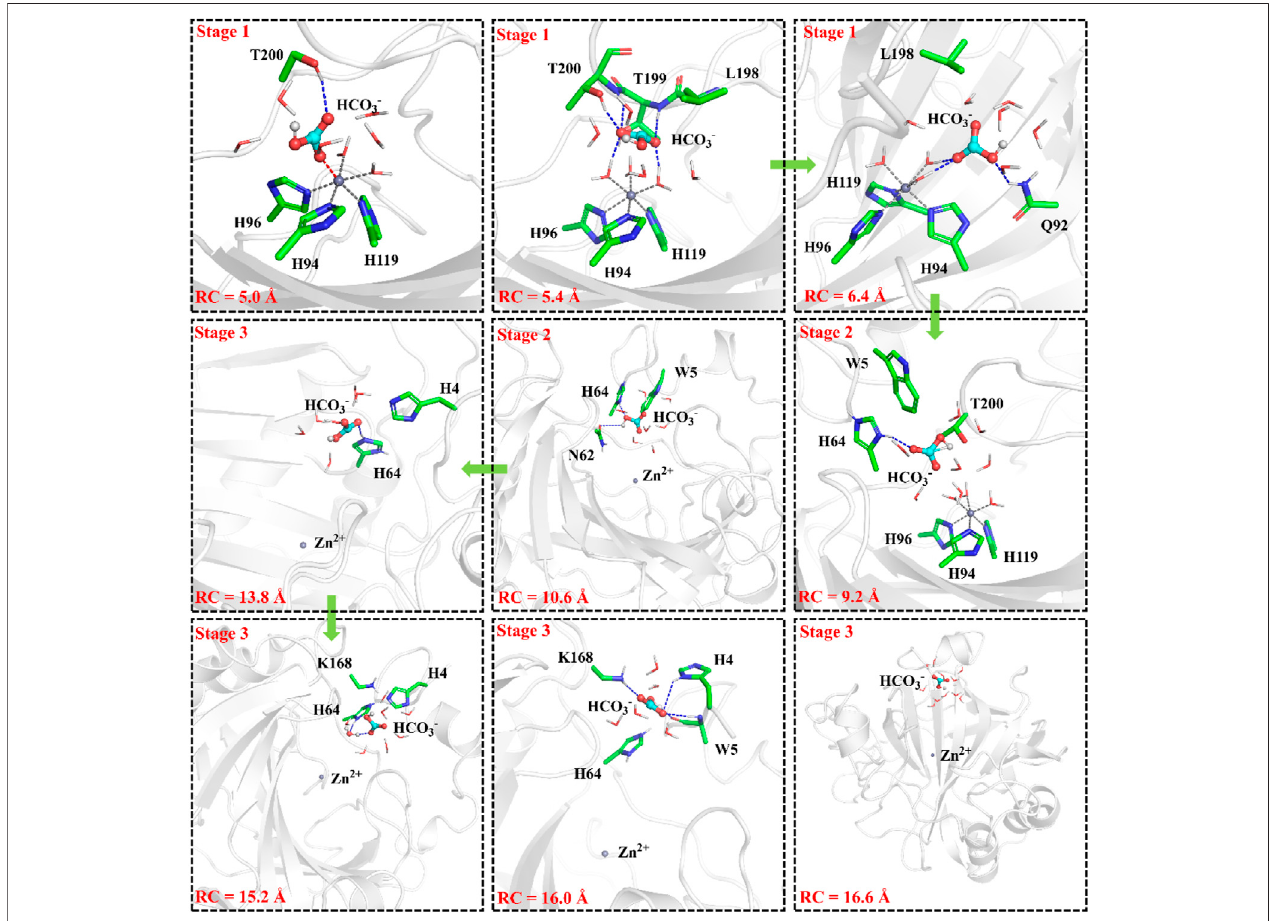
FIGURE 11 | Representative structures and conformational changes of the transportation channel for the release of HCO 3- , where the distance between H119@ NE2 and HCO 3- @C is de fi ned as RC5.